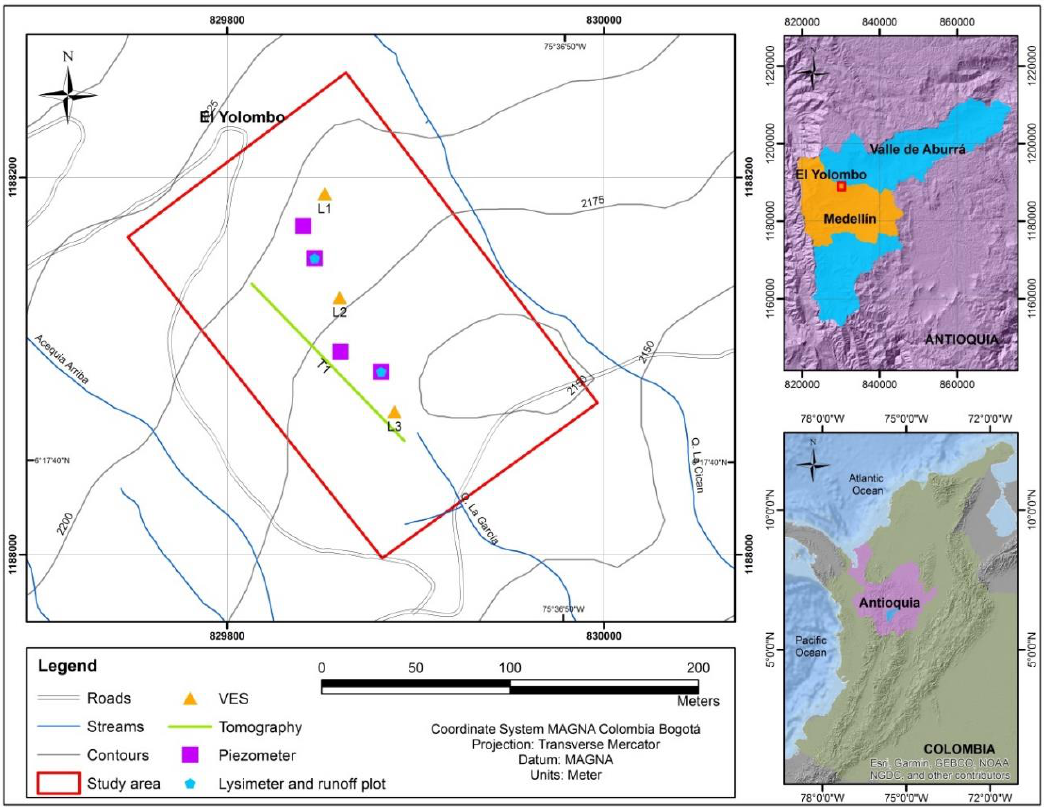
Figure 1. Location of the study area in the locality of El Yolombo on the western flank of the Aburrá Valley where the city of Medellín is located. The studied parcel is depicted with the red box. Measurement locations are also indicated. Piezometers (magenta squares) are numbered from 1 to 4, from top to bottom of the study site.